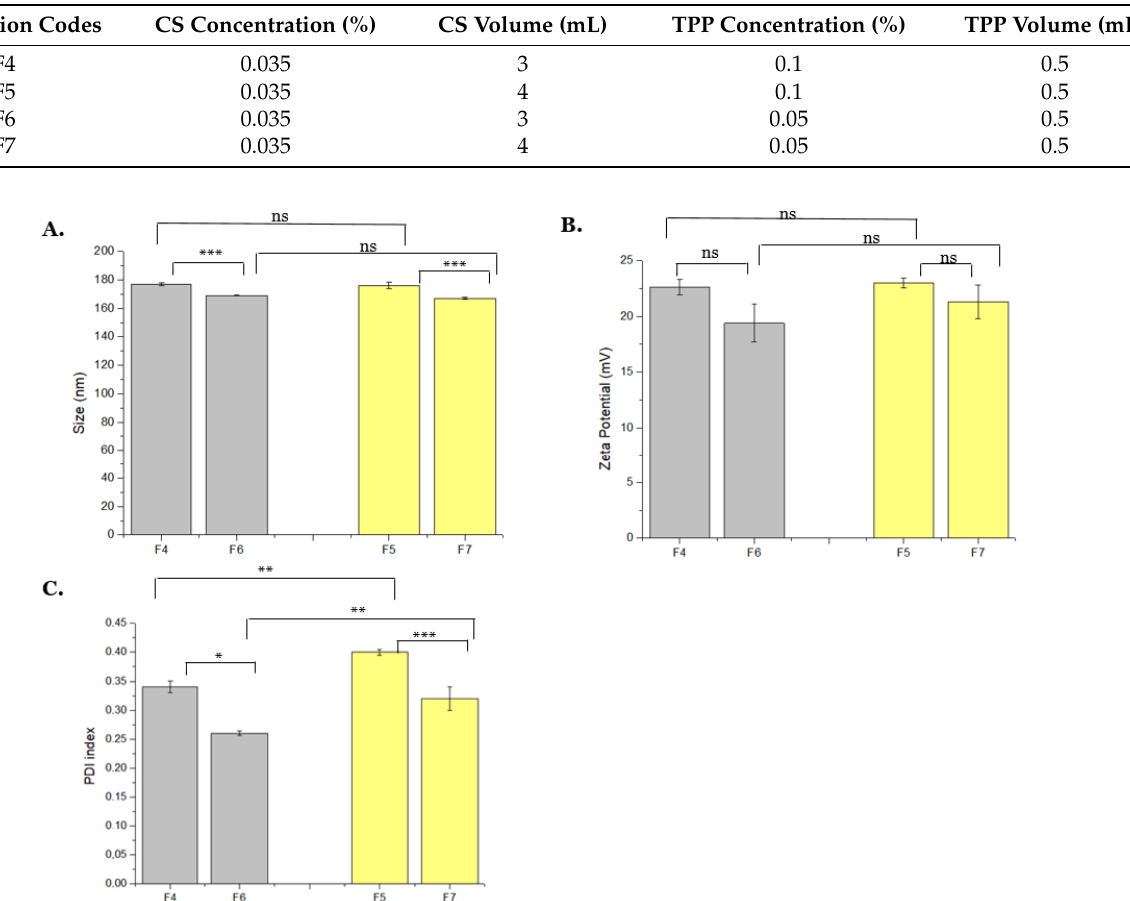
Table 2. Formulations of CS-TPP NPs by changing CS volume and TPP concentration.